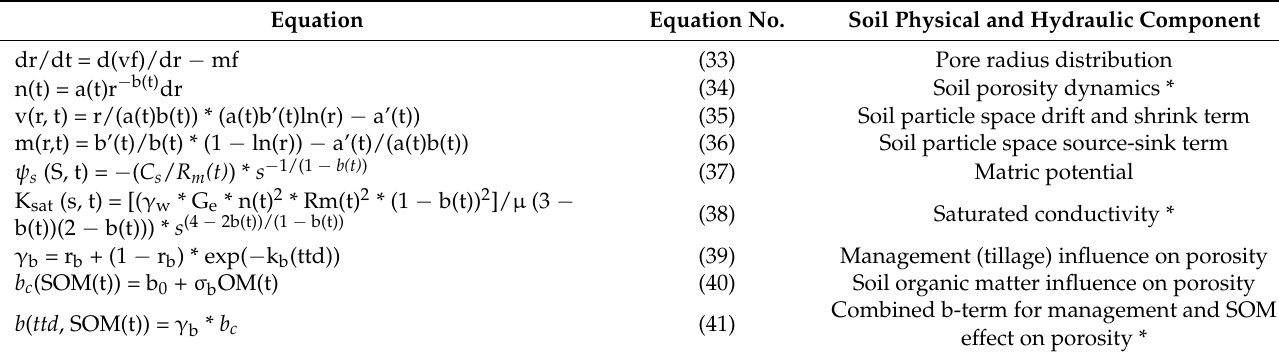
Table 3. Summary list of model physical and hydraulic equations constituting the core structure of the agroecosystem model, developed from [44,45,96,97]. * Descriptions indicate operationalized feedback linkage with other model components. Equation Equation No. Soil Physical and Hydraulic Component Pore radius distribution Soil particle space drift and shrink